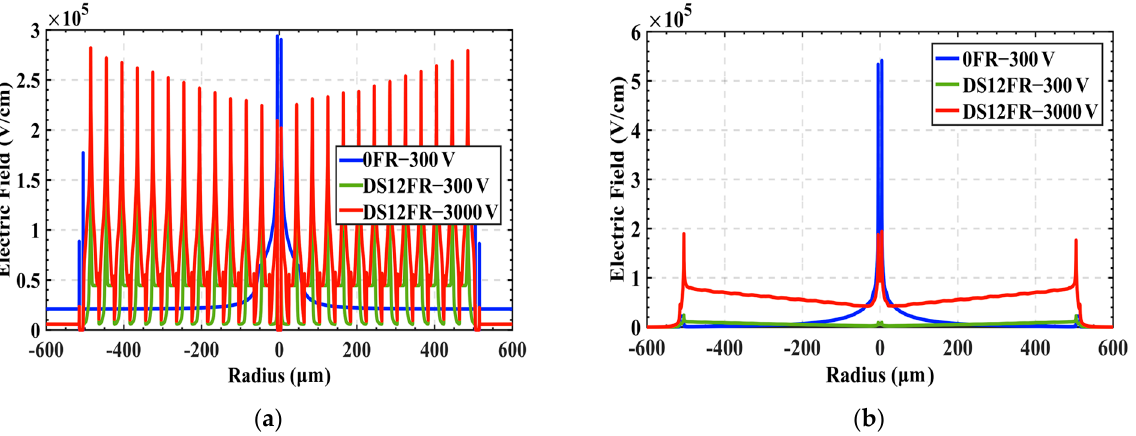
Figure 6. Electric field distribution curves: ( a ) detector surface (thickness = 0 μ m); ( b ) electrode bottom (thickness = 270 μ m).